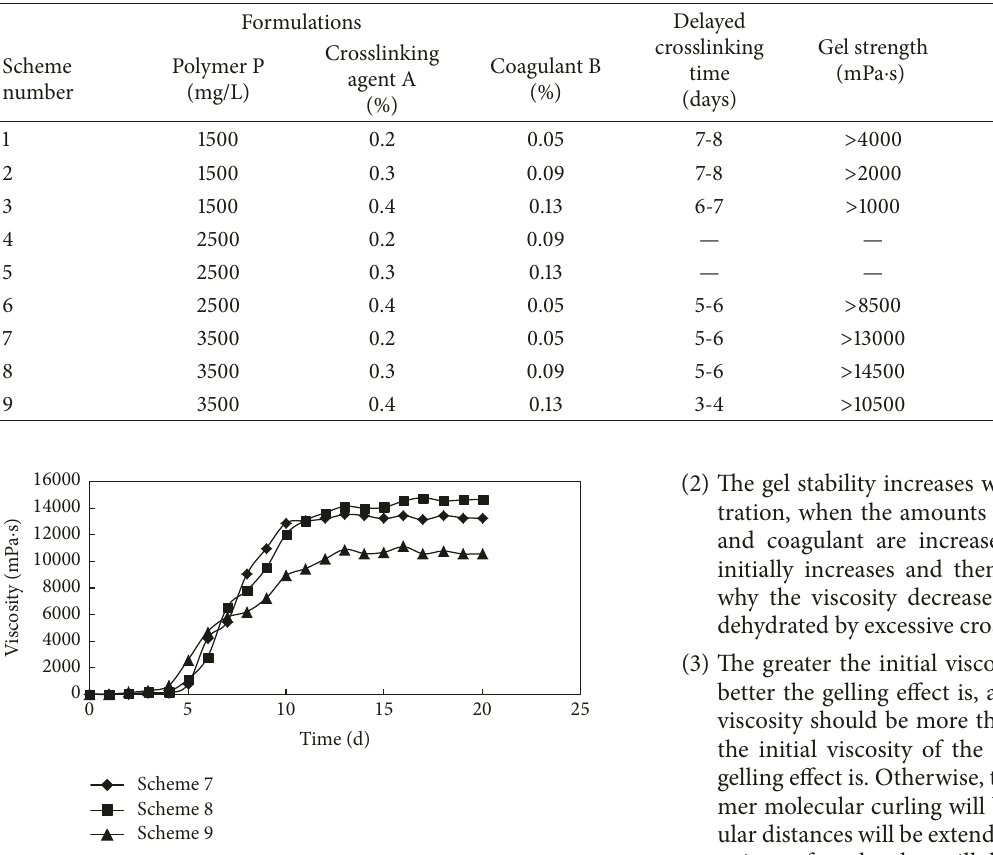
Figure 3: The changing process of viscosity when the concentration of polymer P was 3500